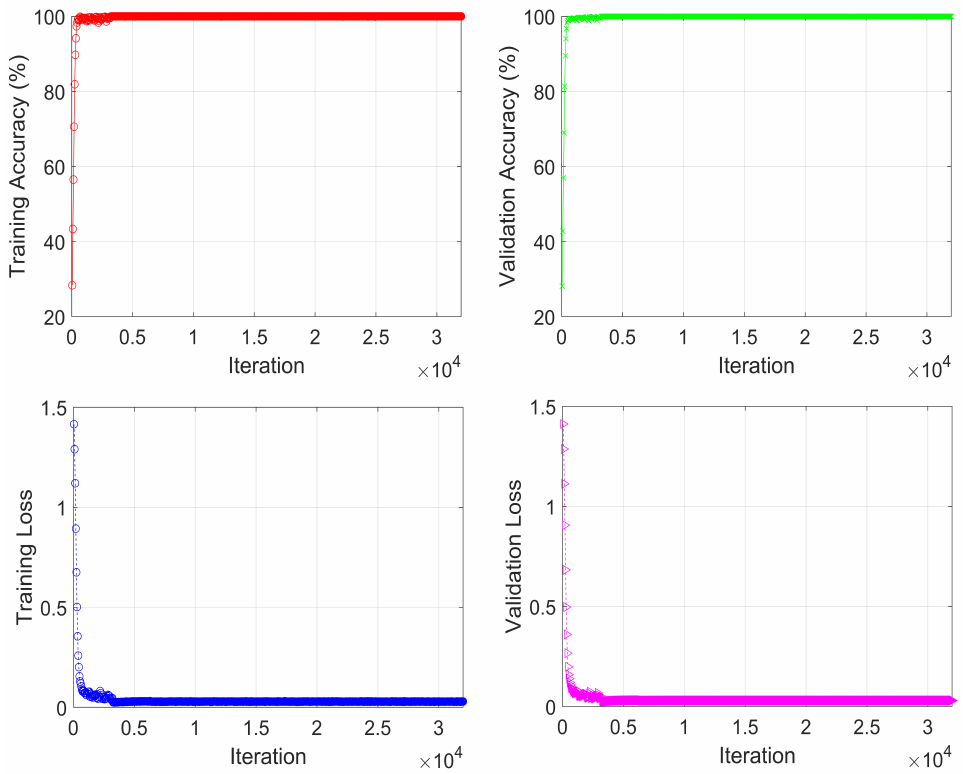
Figure 5. Training and validation progress of the proposed